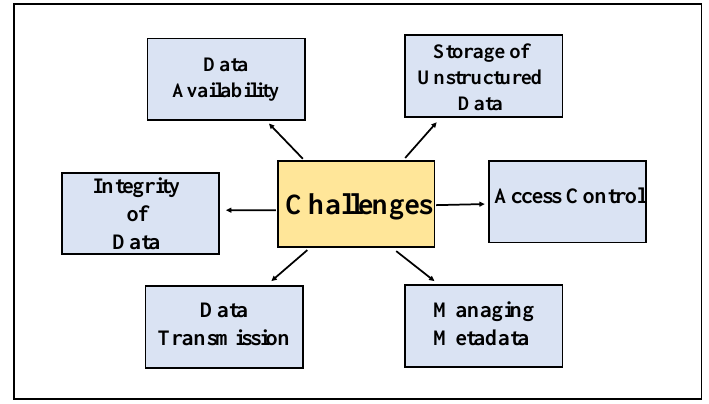
Figure 1. Groundwater data management